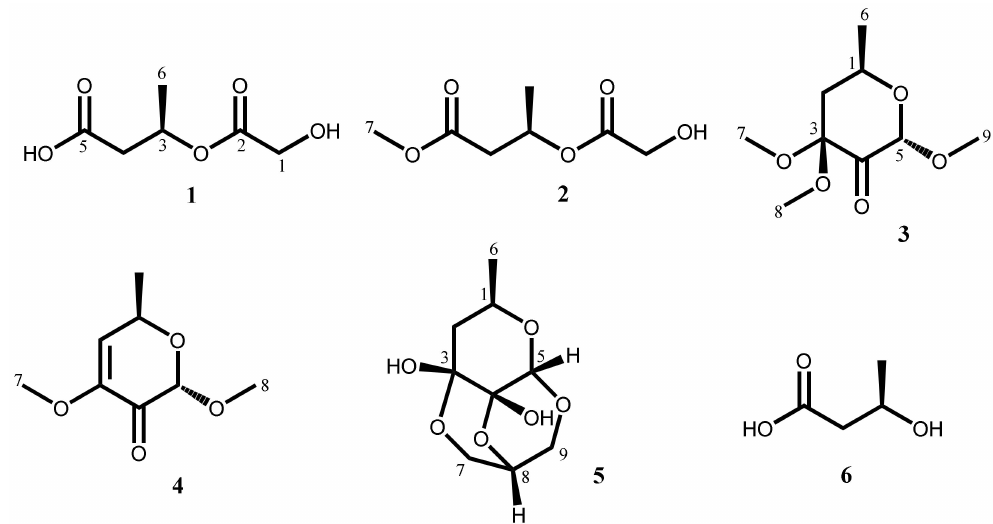
Figure 1. Chemical structures of 1 – 6